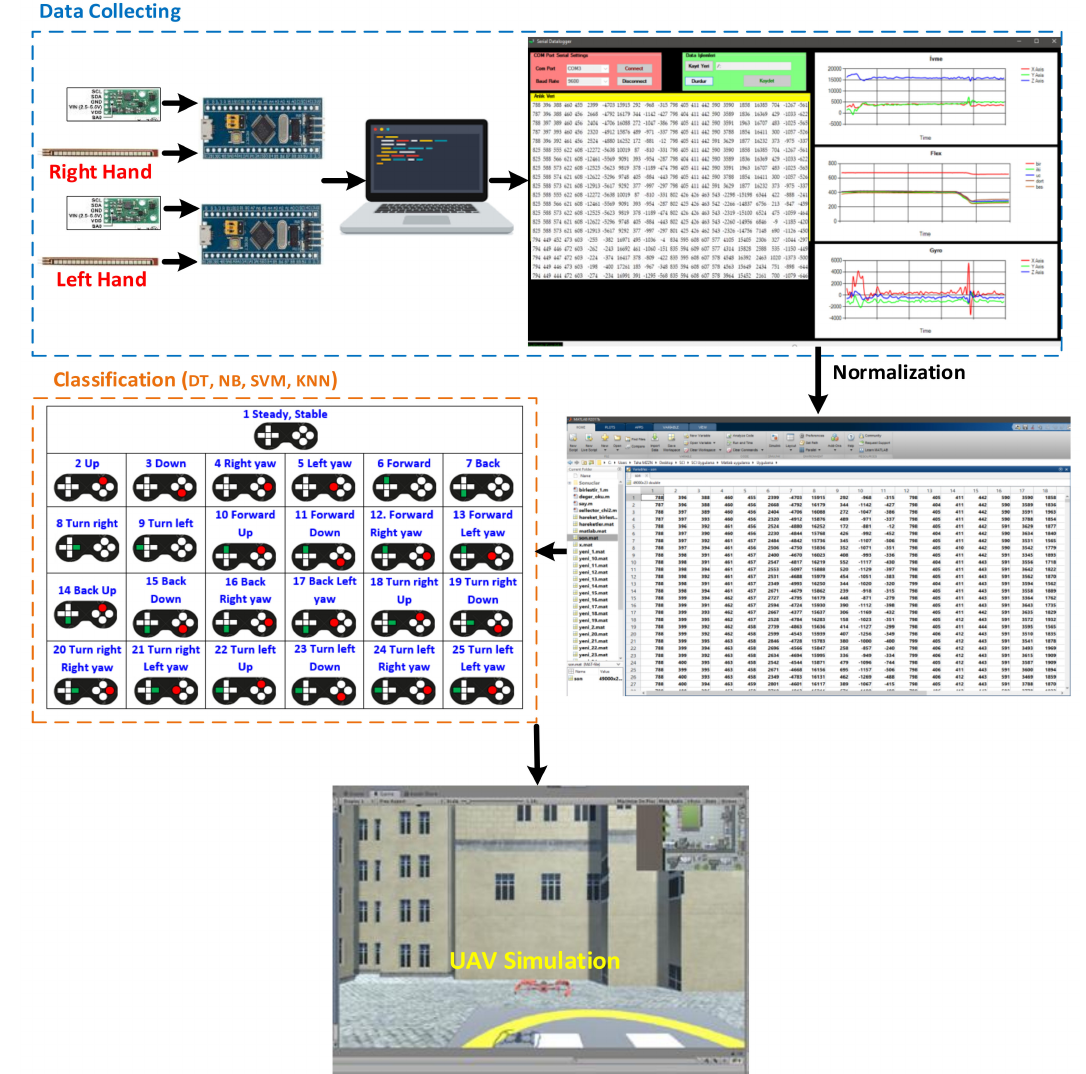
Figure 6. The stages of classifying hand gestures via a pair of smart gloves that can be used in real time with the help of machine learning algorithms and controlling the UAV in a simulation